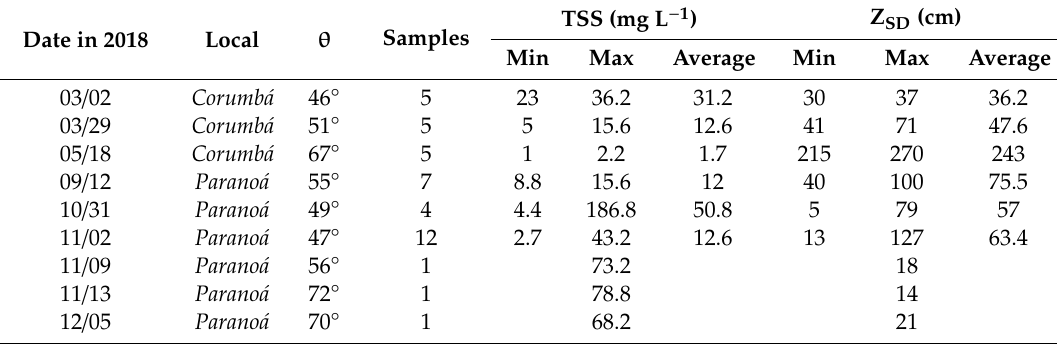
Table 2. Summary of the field sampling trips realized for this